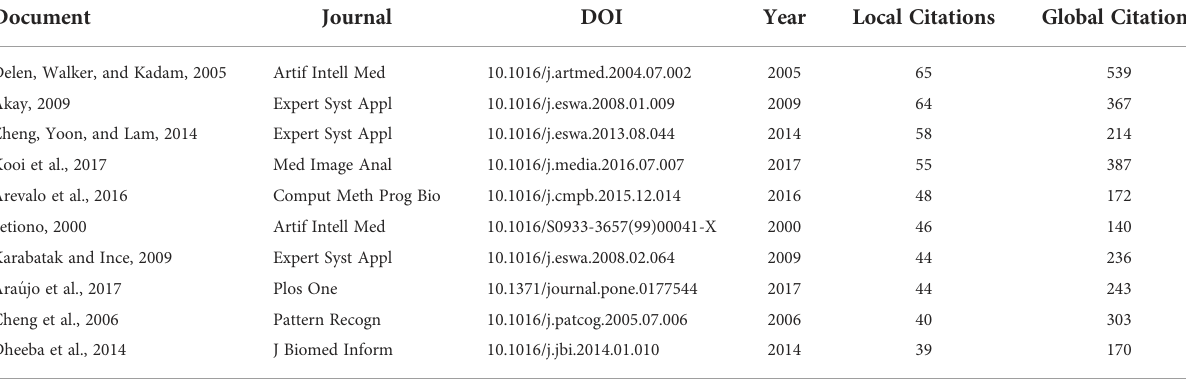
TABLE 4 List of top 10 highly locally cited articles within AI for breast cancer detection and survival prediction research from 2000 to 2021.